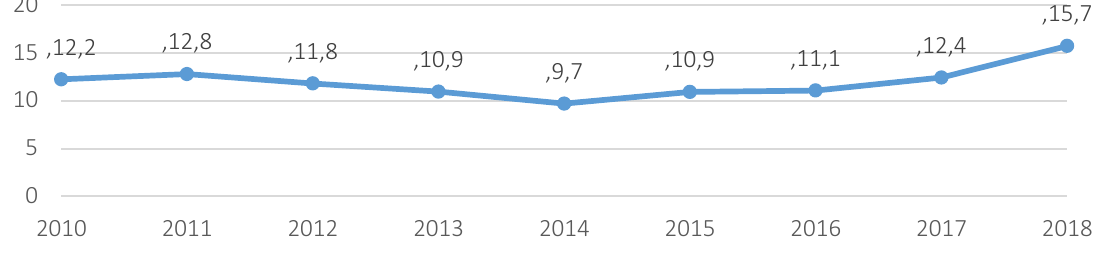
Figure 12. Air emissions from stationary sources of pollution in Odesa